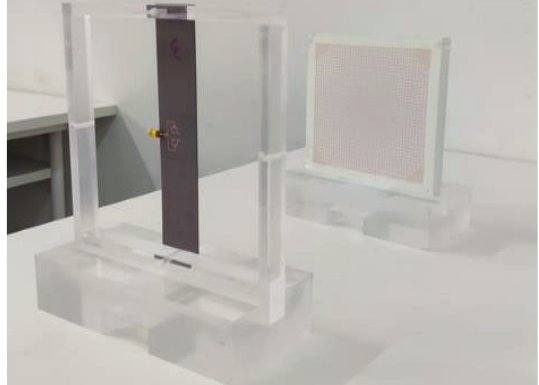
Figure 9. Photograph of the proposed metasurface lens fed by planar 2 × 2 patch-antenna array.